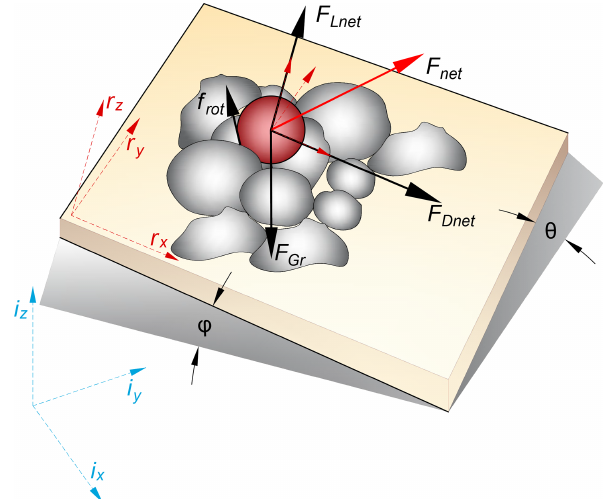
Figure 1. Forces in the Newton–Euler model. The diagram shows the linear forces applied on the centre of the mass of the target par- ticle. F Dnet is the net drag force, F Lnet is the net lift force and F G is the force of gravity (Eq. 1), all analysed in the local static frame r . The rotational component (torques generated by the sur- face force f rot around the centre of the mass of the target particle) is analysed on the body frame of the particle ( b , here depicted as aligned with the static frame r ; the general case is discussed in Ap- pendix A). φ is the downstream slope. For the results presented in this work r x is the downstream direction. Also, for the flume exper- iments there is no cross-stream slope ( θ =